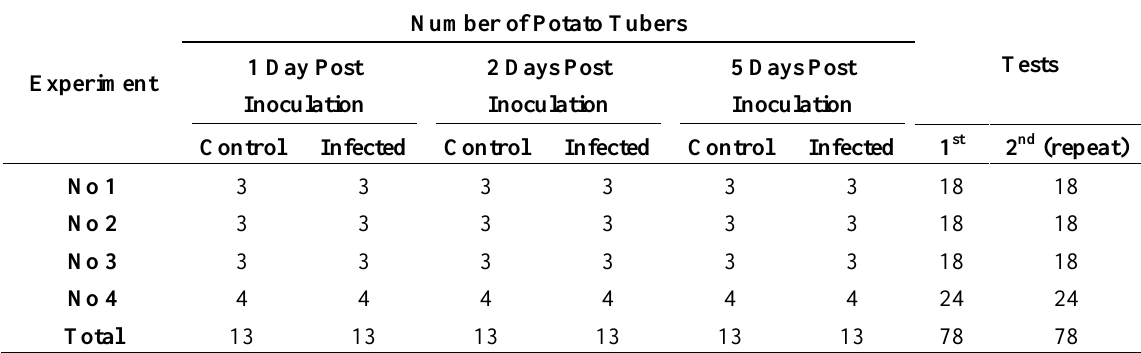
Table 1. Experiments carried out and number of